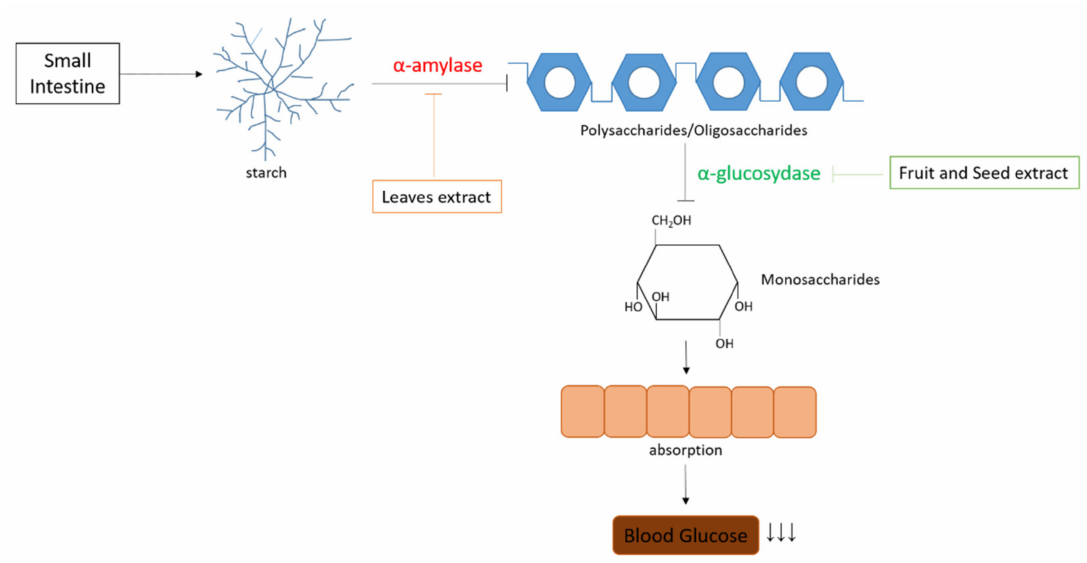
Figure 5. Antihyperglycemic mechanisms of B. macrophylla